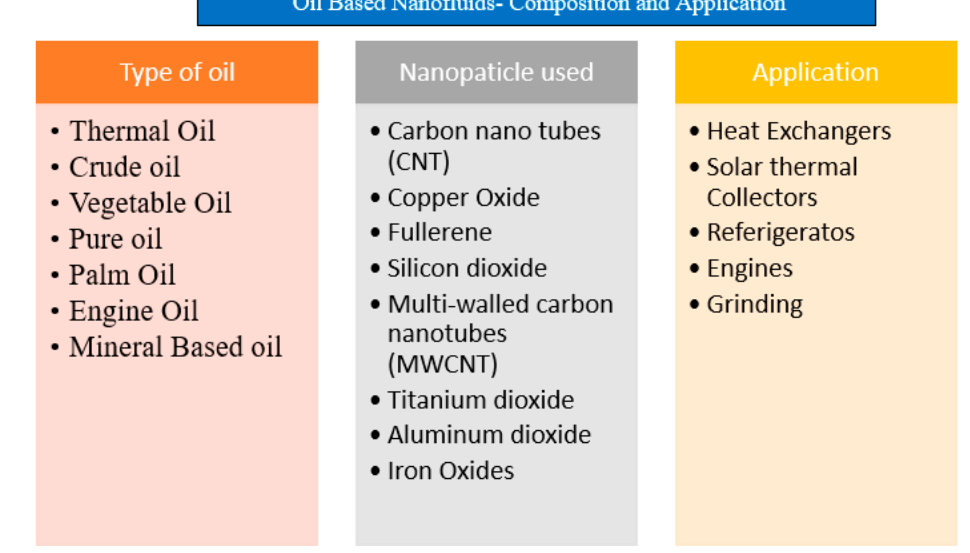
Figure 1. Nanofluid applications.